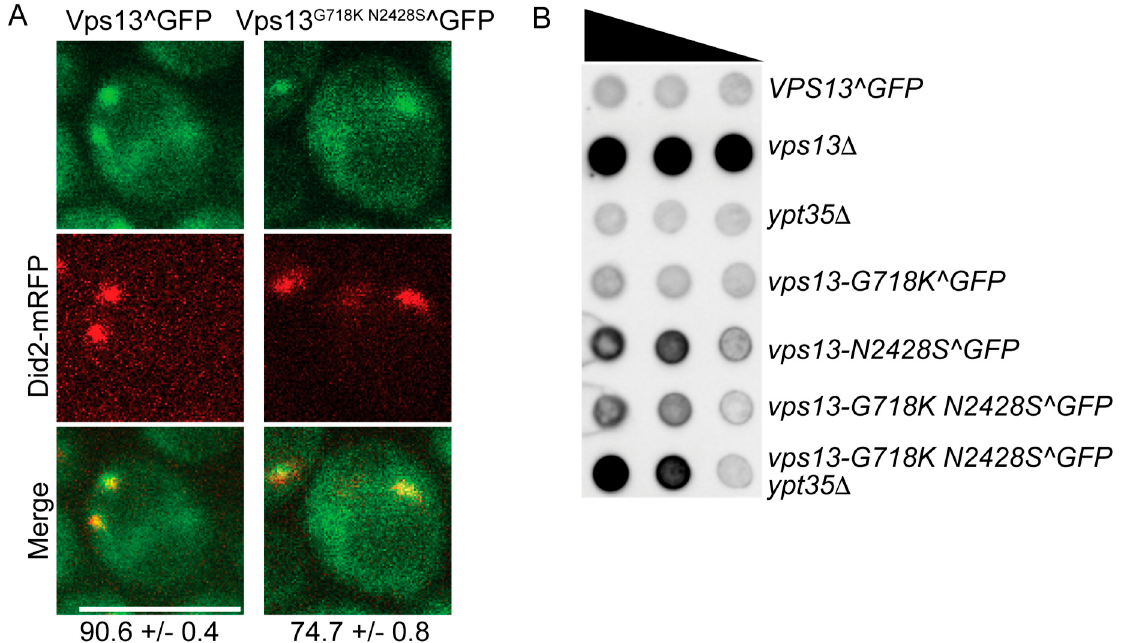
Figure 5. The intragenic vps13-G718K mutation restores endosomal localization of Vps13 G718K N2428S and promotes CPY sorting. ( A ) Colocalization of Vps13^GFP proteins with endosomes. Strains carrying VPS13^GFP (JSP512) or vps13-G718K N2428S^GFP (JSP864) containing the endosomal marker, DID2-mRFP , were grown in SD complete medium and collected at mid-log phase for microscopy [39]. Scale bars = 5 µm. Numbers at the bottom indicate the percentage of Vps13 foci that co-localized with the Did2-mRFP marker (± one standard deviation). Two experiments with at least 100 foci were scored for each experiment). ( B ) CPY sorting. The indicated strains were assayed for CPY sorting as described in Figure 4 except that 4-fold serial dilutions were used; VPS13 ^GFP (JSP497), vps13 ∆ (KO1), ypt35 ∆ (KO6), vps13-G718K^GFP (JSP531), vps13-N2428S^GFP (JSP816), vps13-G718K N2428S^GFP (JSP832) and vps13-G718K N2428S^GFP ypt35 ∆ (JSP856).